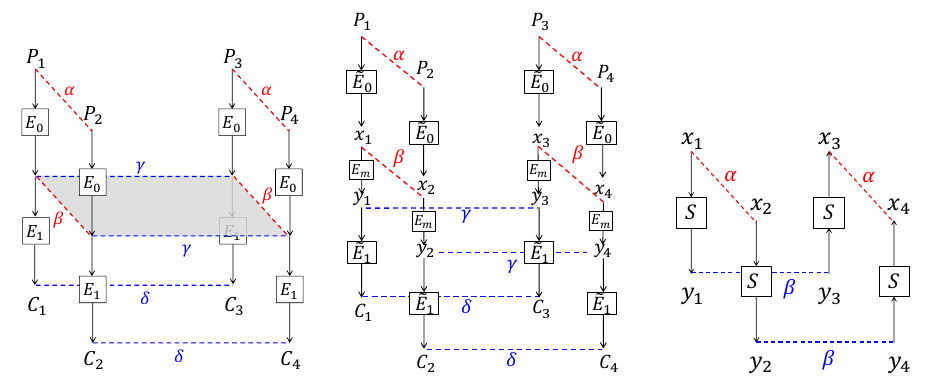
Figure 1: Basic boomerang attack (left), sandwich attack (middle) and E m with only an S-box